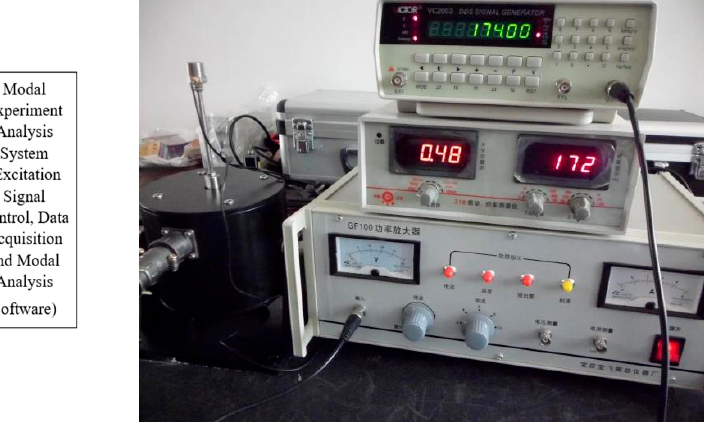
Figure 3. Flowchart of the mode experiment system.